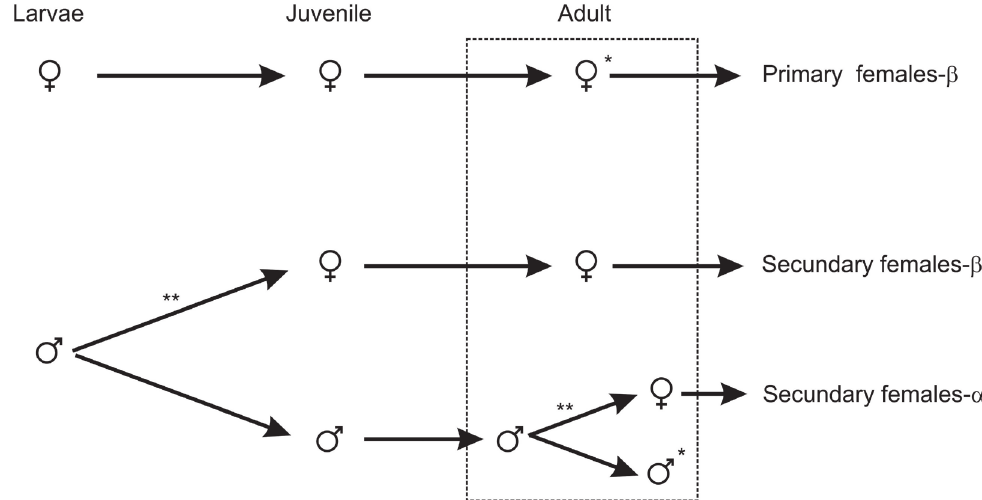
Fig . 7. – sexual development of H. inermis . summary of life cycle strategies extracted form literature and the present work. *: gonochoric condition. ** sex determination or sex reversal α, β : following zupo. Primary: without sex reversal. secondary: with sex